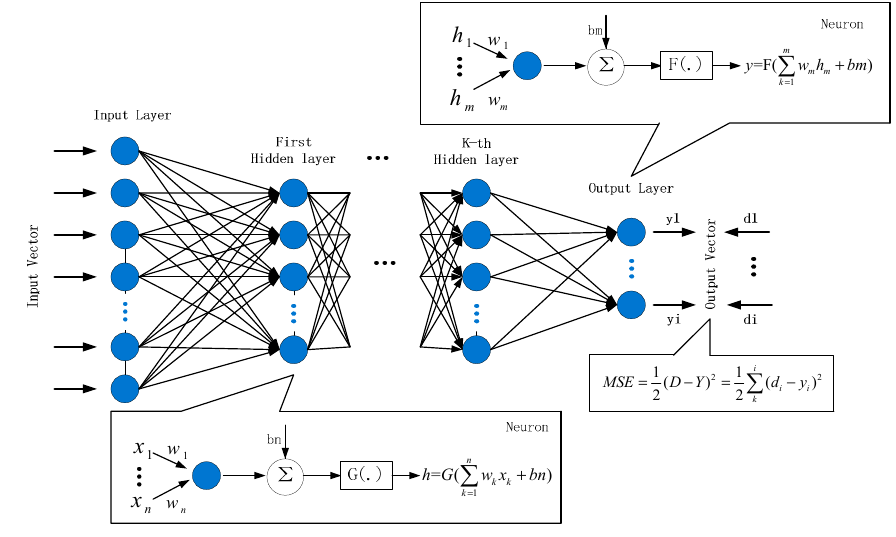
Figure 4. Block diagram of deep neural network.